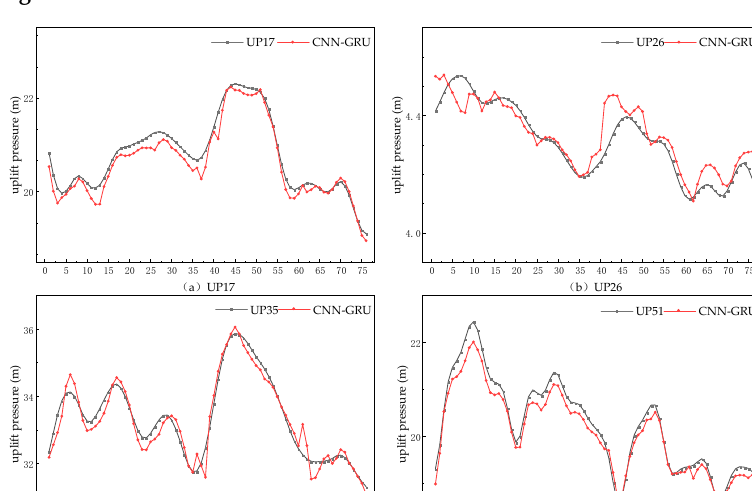
Figure 8. Iterative loss value curve.